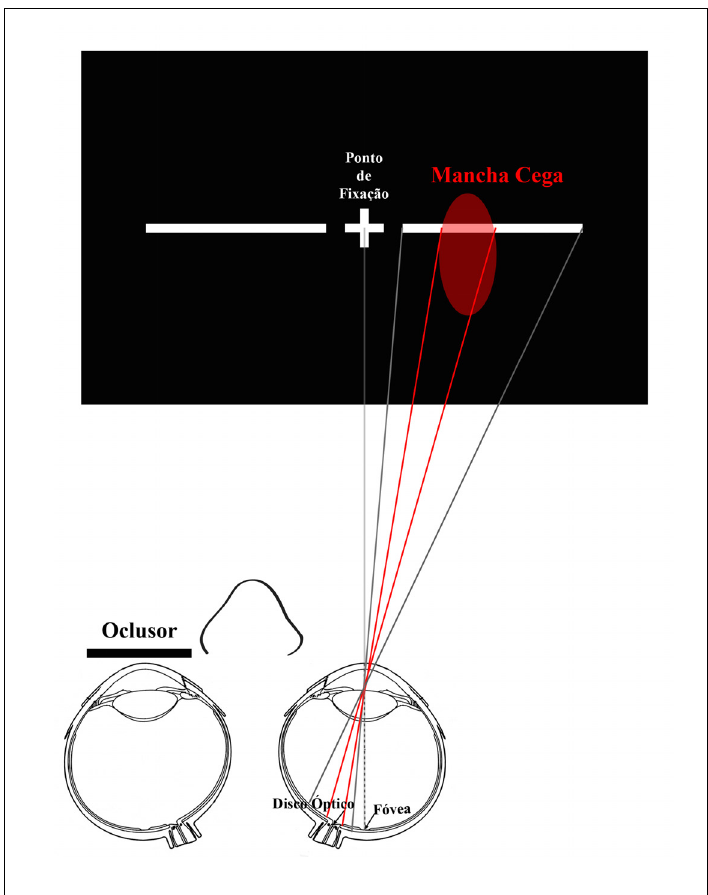
Figura 1 . Esquema da situação experimental para a apresentação dos estímu- los das comparações de barras